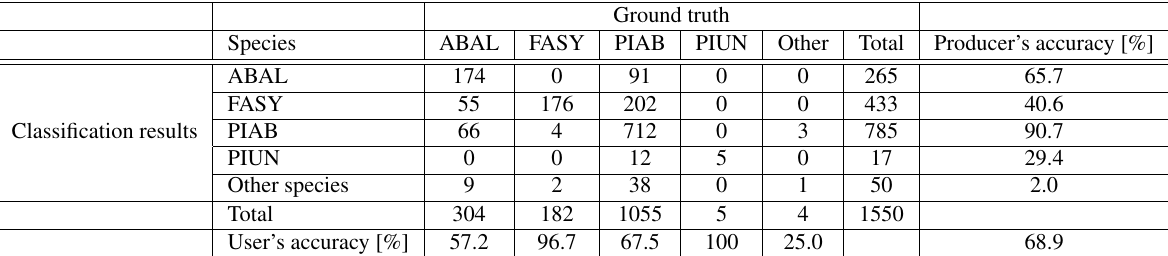
Table 7: Species classification results at pixel-level obtained by the fusion of HI and LiDAR features Ground truth